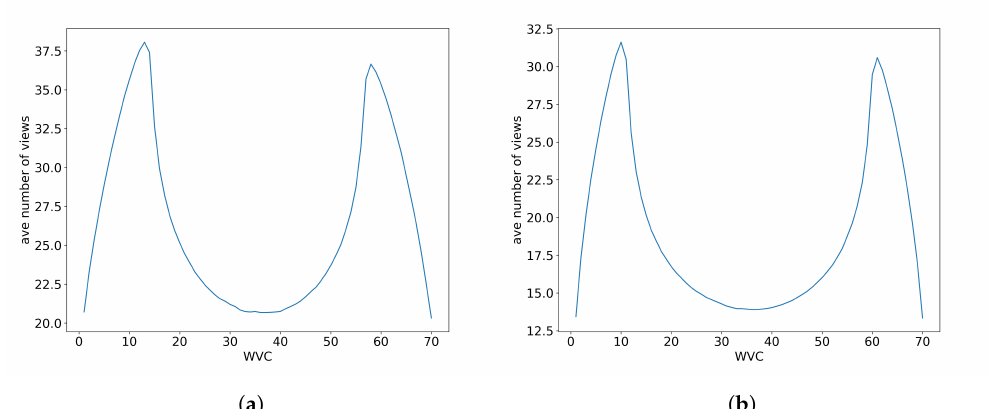
Figure 1. WindRAD rotating fan-beam illustration.